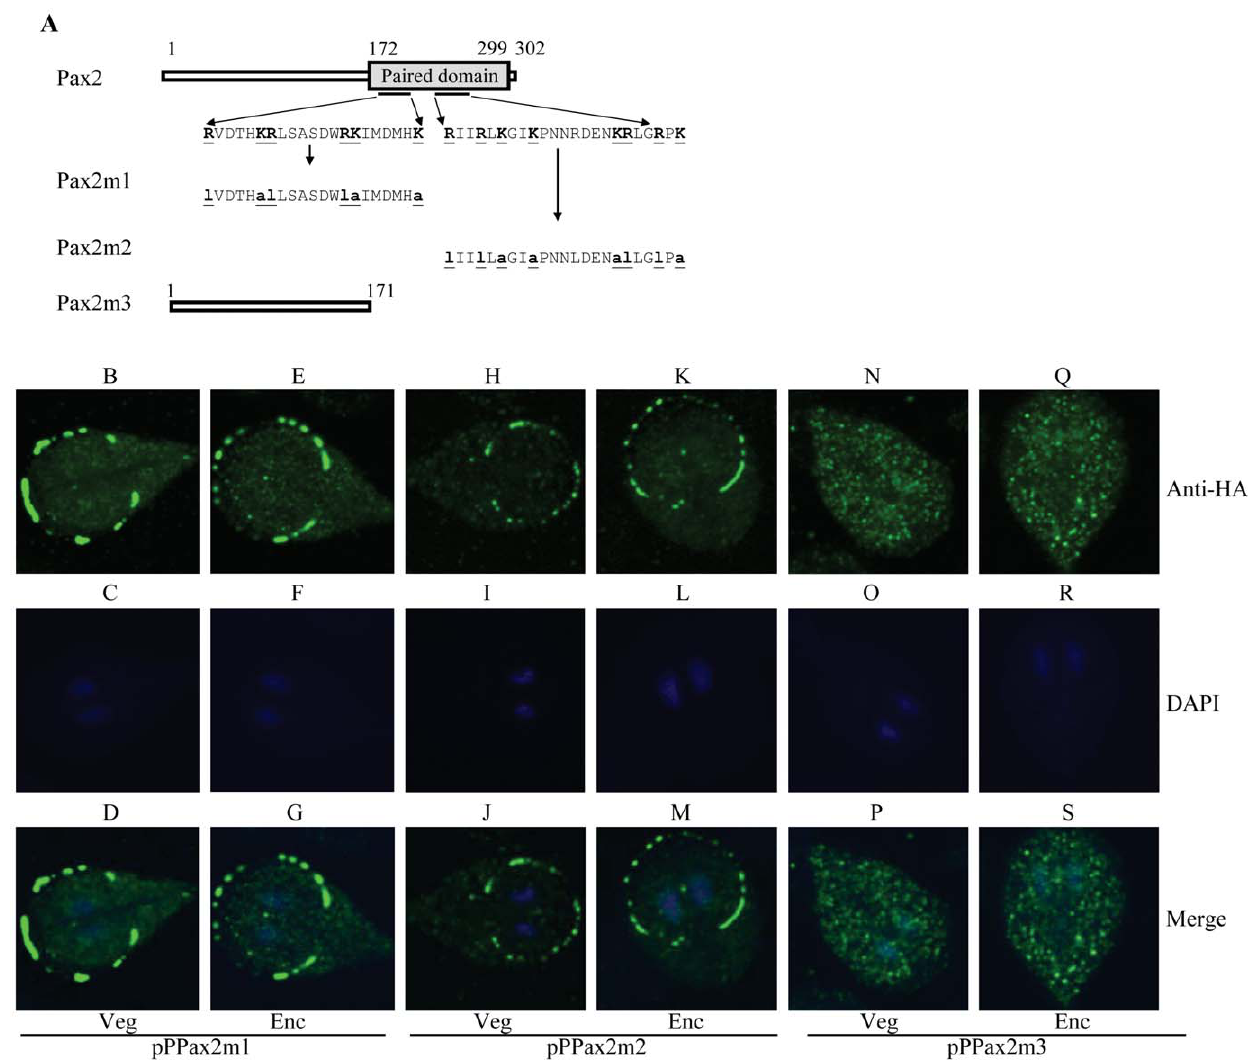
Figure 3. Localization of Pax2 mutants. (A) Diagrams of the Pax2 and Pax2m1-3 proteins. The gray box indicates the paired domain. Pax2m3 does not contain the C-terminal paired domain and C-terminal region (residues 172–302). Pax2m1 and Pax2m2 contain a mutation of two stretches of basic amino acids located inside of the paired domain (residues 185–205 for Pax2m1; residues 226–248 for Pax2m2). The pax2 gene was mutated and subcloned to replace the wild type pax2 gene in the backbone of pPPax2 (Figure 2C), and the resulting plasmids pPPax2m1-3 were transfected into Giardia . (B) Immunofluorescence analysis of Pax2m1-3 distribution. The pPPax2m1-3 stable transfectants were cultured in growth (Veg, vegetative growth) or encystation medium for 24 h (Enc, encystation) and then subjected to immunofluorescence analysis using anti-HA antibody for